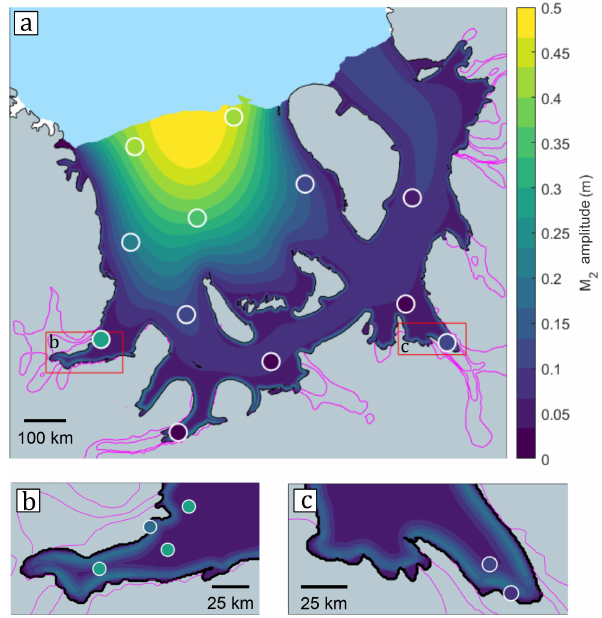
Figure 3. Amplitude of modelled horizontal ice shelf displace- ments at the M 2 frequency (background colour map) compared with GPS observations (circles). Magenta lines are 0.5md − 1 ice veloc- ity contours, to help identify regions of fast flowing grounded ice. Grounded ice and open ocean are coloured grey and blue, respec- tively, and ice shelves not included in the model domain are white. Panels (b) and (c) show magnified maps of EIS and FIS, respec- tively. Additional GPS sites are shown in these sub-panels that are not shown in panel (a) for the sake of